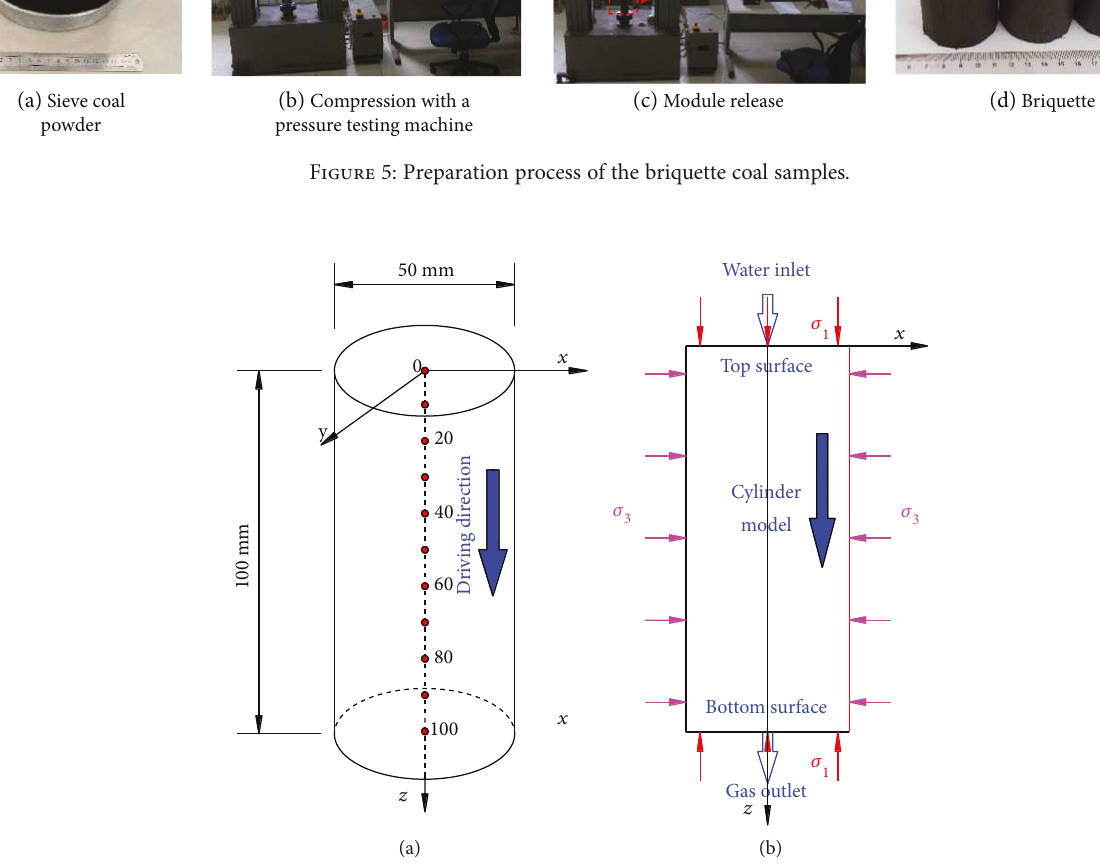
Figure 6: Schematic diagram of the geometric model (a) and imposed constraints